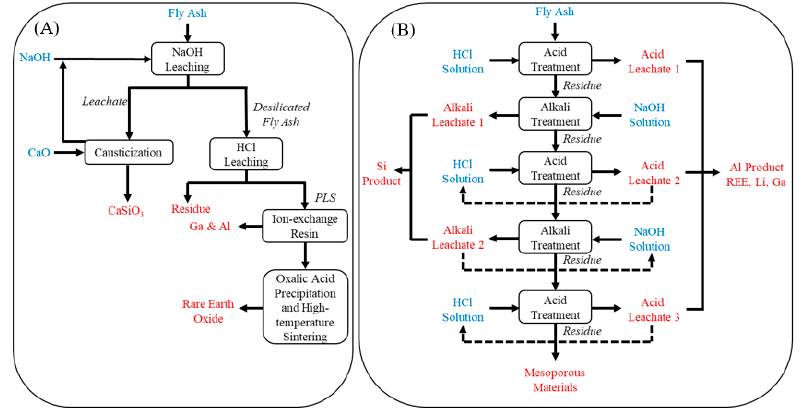
Figure 8. Flowsheets reported in the literature for recovering REEs from coal combustion ash using NaOH hydrothermal treatment followed by acid leaching: ( A ) reported by [18] and ( B ) reported by [98].